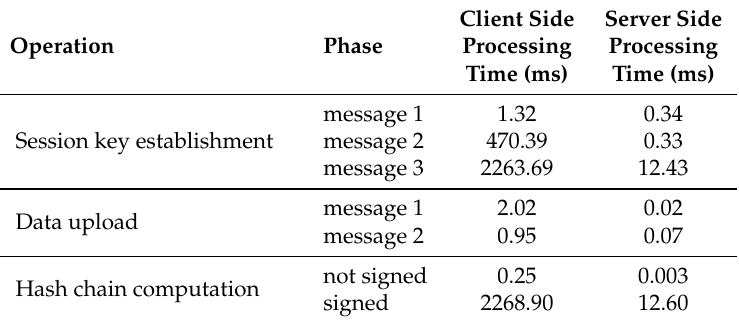
Table 4. Protocol processing time